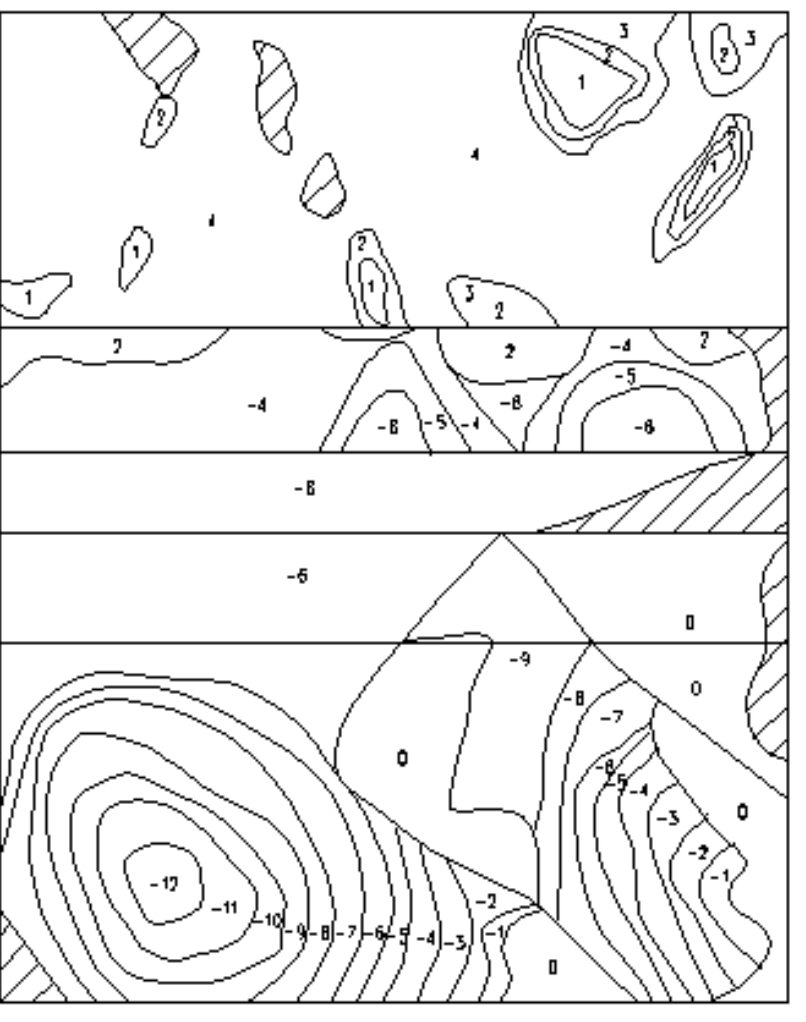
Figure 21. Sketched contour of the foundation rock mass surface after the overloading test (3 × design load).